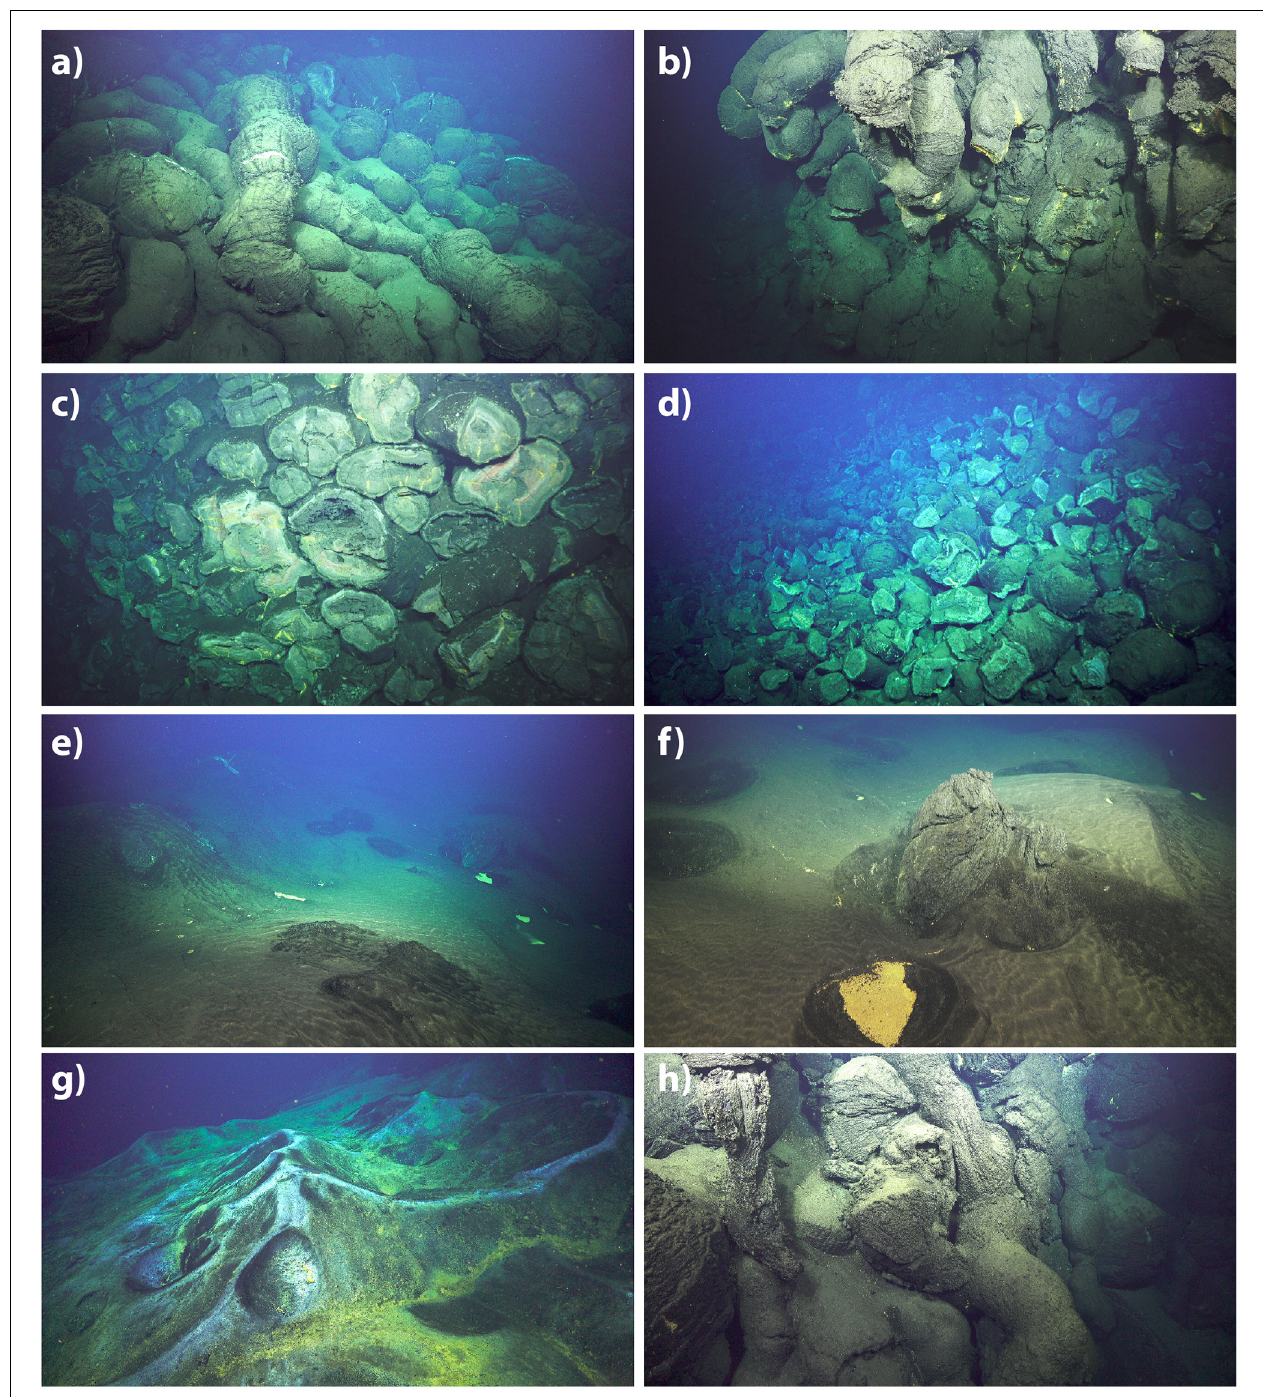
FIGURE 6 | Images of eruption site #1 from ROV SuBastian dive S86. All are 2016–2017 eruption products. Numbers in parentheses are time of photo in GMT and horizontal scale. See Figure 5d for photo locations. (a) Pillow lavas on the slope below the rift zone (19:17:22, 5 m). (b) Nearly vertical cliff face of intact pillow lavas (20:09:42, 4 m). (c) Nearly vertical cliff of truncated pillows on the headwall of a landslide scarp (20:52:51, 4 m). (d) Talus with pillow fragments below a landslide scarp (20:48:50, 10 m). (e) Tephra-covered pillow lavas on a shingled lava plateau near the eruptive fissures, with circular pits containing yellow microbial floc in the distance (21:40:18, 10 m). (f) Closer view of collapse pit in tephra deposit with yellow microbial floc (bottom) and large partially buried pillow at center (21:47:06, 4 m). (g) Colorful microbial mats growing on tephra completely burying pillow lavas on a shingled lava plateau near the eruptive fissures (23:41:48, 6 m). (h) Exposed tubular pillow lavas on the steep step between shingled lava plateaus (22:27:47, 3 m).